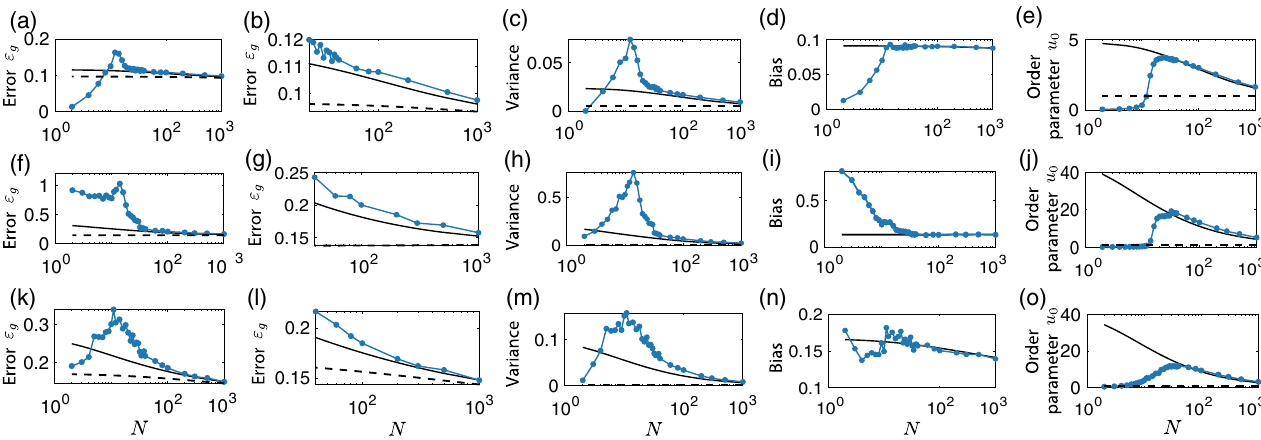
FIG. 14. Single hidden-layer ReLU network with smaller N 0 to push the network closer to its capacity. Black solid lines: theory. Blue lines: simulation. Black dashed lines: GP limit. (a,f,k) Generalization error [(b,g,l) zooming in on the large N part of (a,f,k) to show the convergence to the theory and to compare our ansatz with the GP approximation], (c,h,m) variance, and (d,i,n) bias of the predictor, and (e,j,o) the order parameter u 0 . (a) – (e) Trained on the linear teacher task with detailed parameters in Appendix E. The minimum generalization error is observed at small N , on the lhs of the interpolation threshold due to the linearity of the task. (f) – (j) Trained on the template model with random labeling of each cluster (see detailed parameters in Appendix E). The task itself requires nonlinearity, and the minimum generalization error is achieved in the overparametrized regime. (k) – (o) Trained on the randomly projected MNIST data of two digits (see Appendix E). This task also requires nonlinearity, and the minimum generalization error is achieved in the overparametrized regime. [In this figure, we also use the finite T ansatz (see Ref. [33], Sec. VII) for the theory